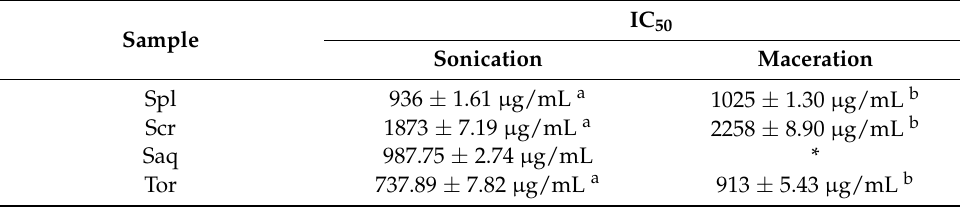
Figure 3. The effect of extraction techniques, ultrasonic-assisted extraction (UAE/sonication) and cold maceration, on the percentage of radical scavenging activity of four brown algae; Sargassum polycystum (Spl), Sargassum cristaefolium (Scr), Sargassum aquifolium (Saq) and Turbinaria ornata (Tor). Results are expressed as mean ± SD. Table 1. IC 50 values for ABTS scavenging of four brown algae species.